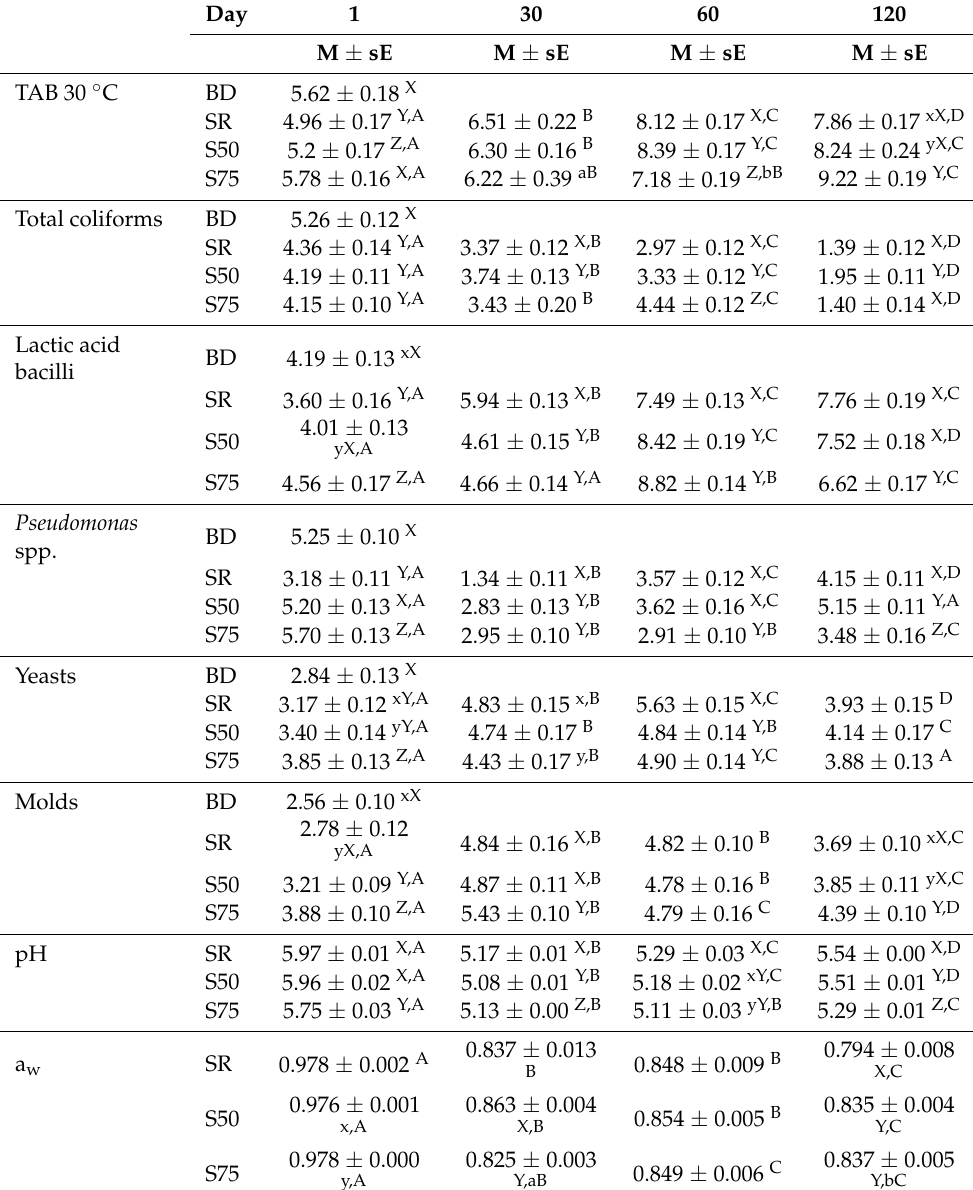
Table 1. Microbiological and physicochemical